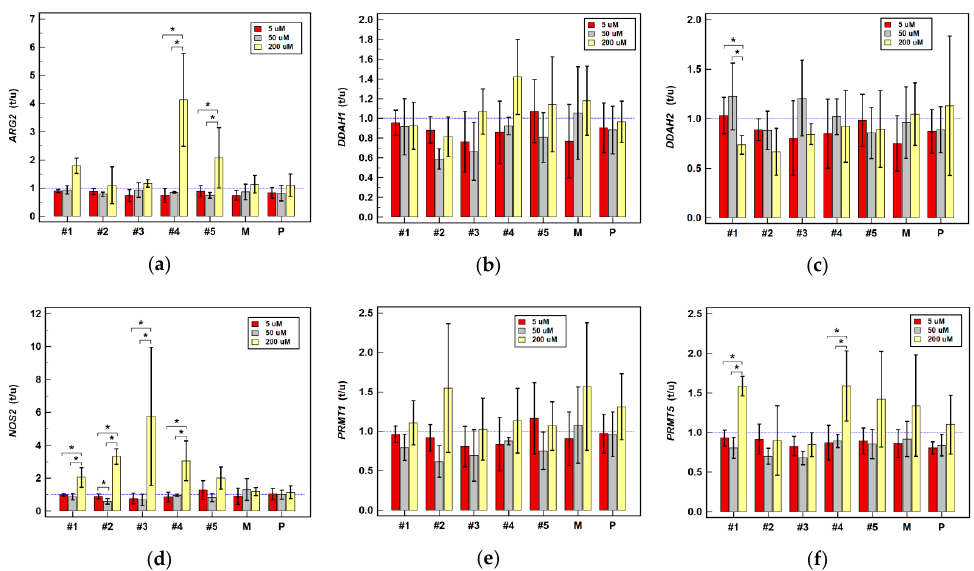
= M ↓ 1.2 2 Results of paired analysis showing a relative increase ( ↑) or decrease (↓) in gene expression normalized to GAPDH in treated as compared to non-treated cells (24-h incubation with indicated drug concentration). Data are presented as mean of three independent experiments and were analyzed using t -test for paired samples. Comp., compound; HCT, HCT 116 cell line; P, piroxicam;